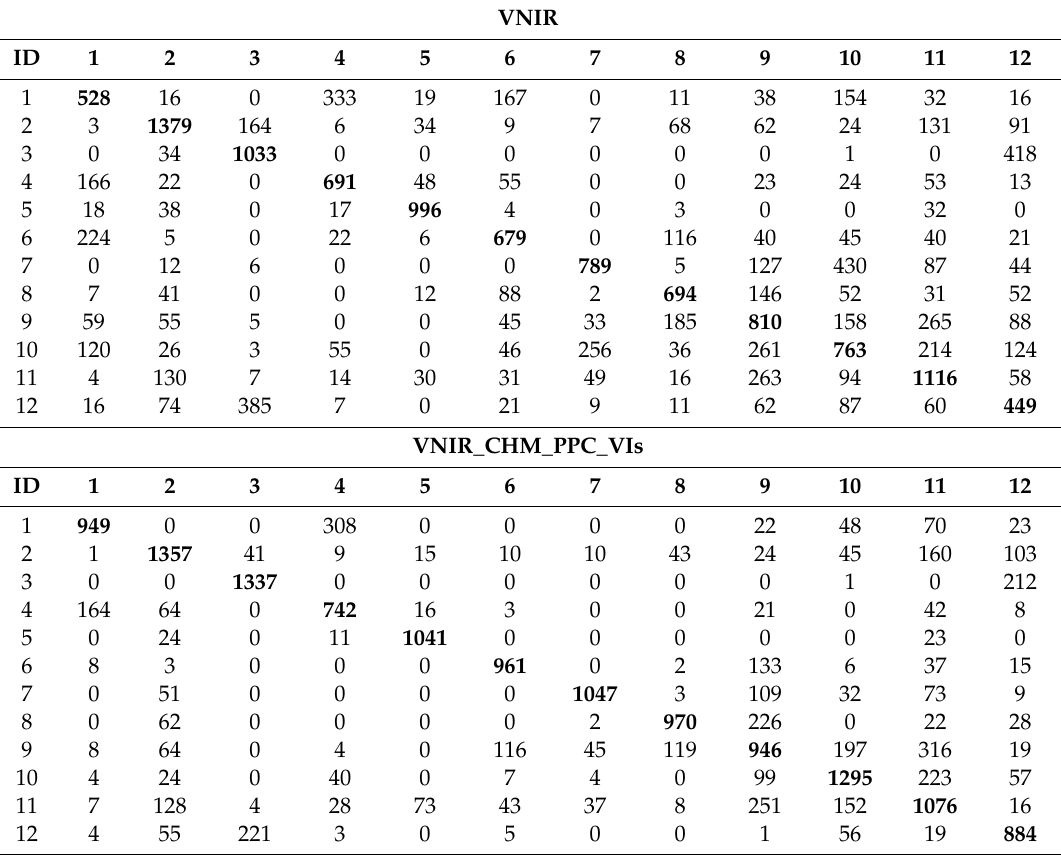
Table 8. Confusion matrices of the classification using the VNIR dataset and the dataset with the best result